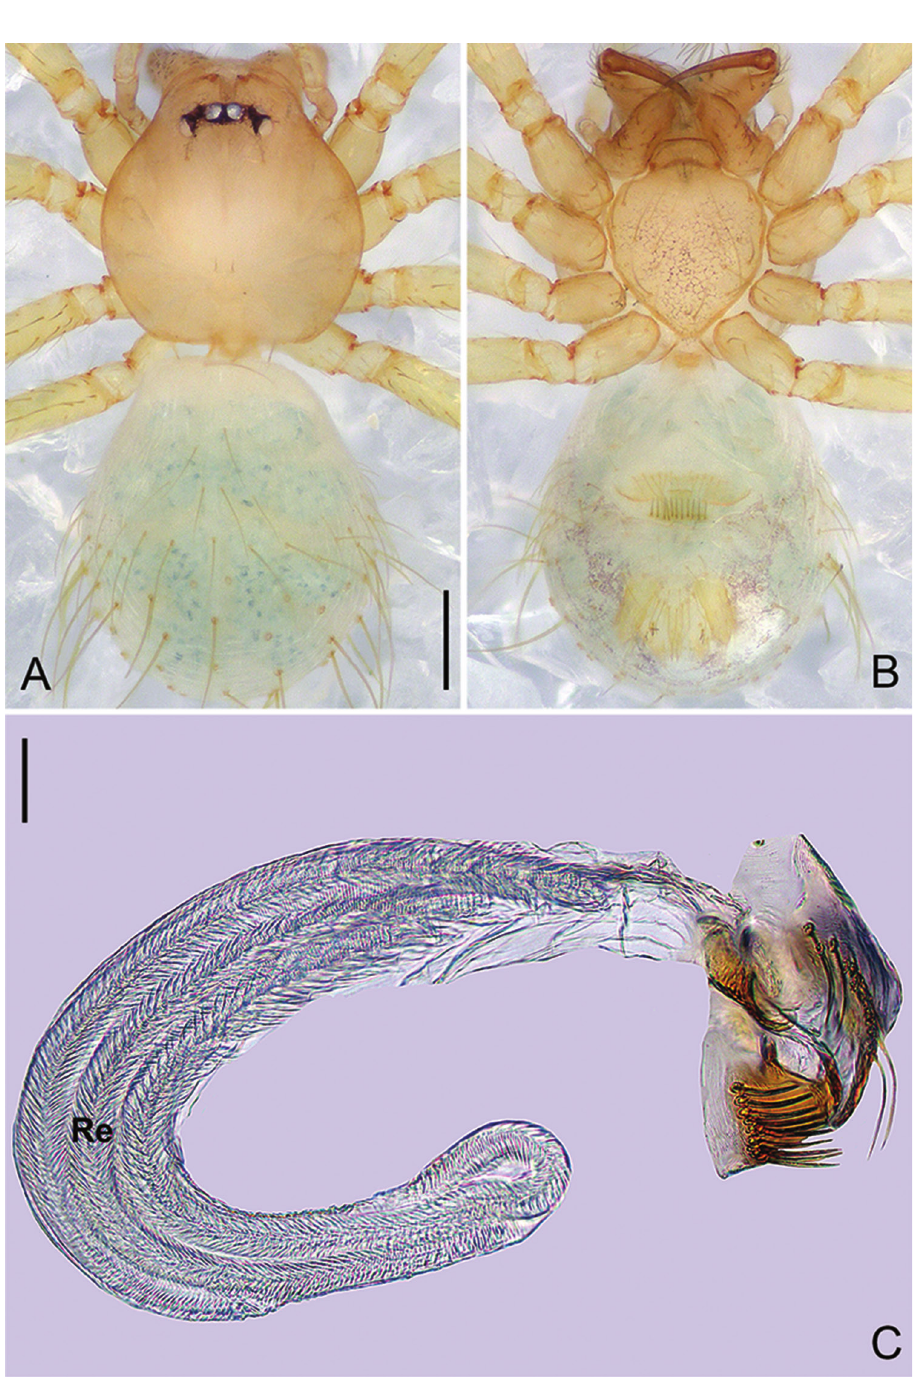
Figure 4. Pinelema cheni Zhao & Li, sp. n., female paratype. A Habitus, dorsal view B Habitus, ventral view C Endogyne, lateral view. Scale bars: 0.2 mm ( A–B ), 0.05 mm ( C